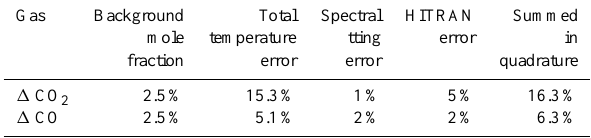
Table B1. Totals and component values of the uncertainty budget for calculating 1 [CO 2 ] and 1 [CO].